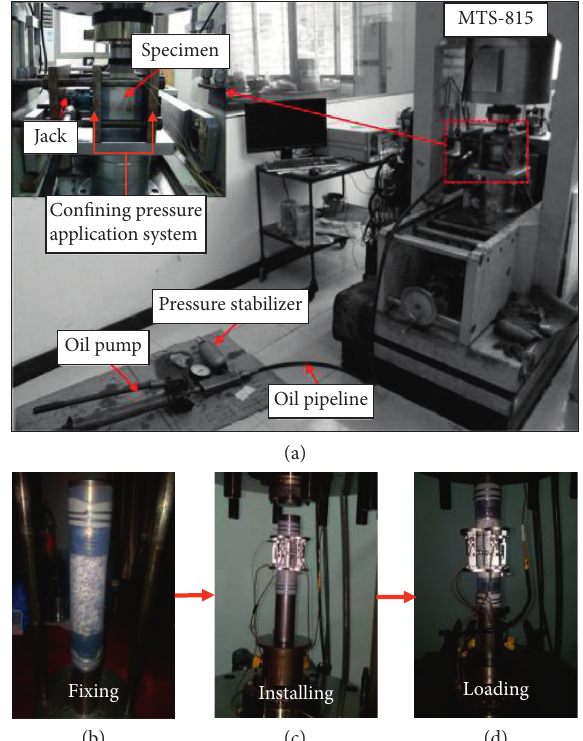
Figure 2: Triaxial compression test process. (a) MTS-815 testing system. (b) Sample fixing. (c) Sample installing. (d) Sample loading.